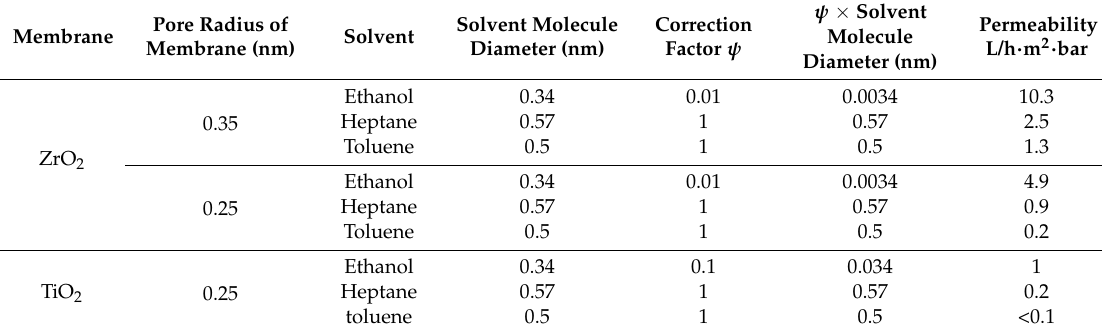
Table 2. Solvent permeability through the ceramic membrane reported by [46] through ZrO 2 and TiO 2 membranes.